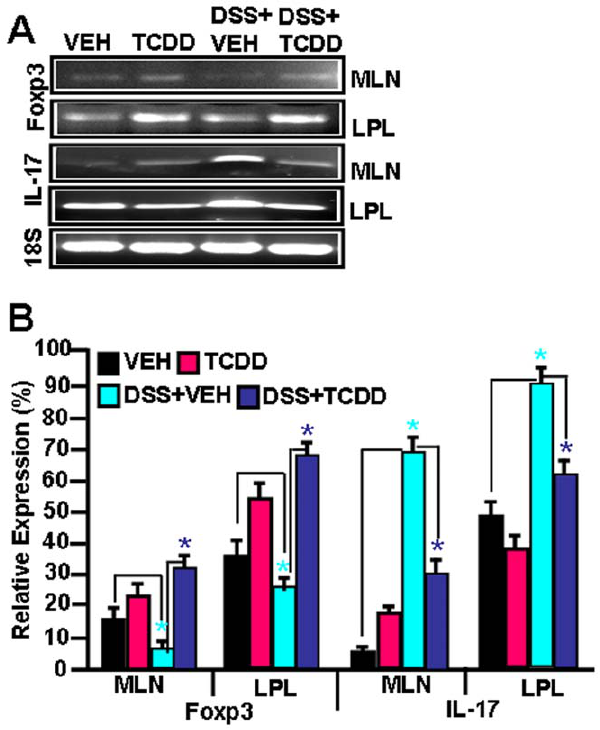
Figure 3. Effect of TCDD administration invivo on Foxp3 and IL-17 expression in lymphoid organs during colitis. MLN, and LP cells were isolated on day 14 of colitis from the 4 groups of mice as described in Fig. 1. RT-PCR was used to detect mRNA levels for Foxp3 and IL-17 (panel A) and data from 3 independent experiments in each group is shown in panel B. Vertical bars represent mean + / 2 SEM of three independent experiments. Comparisons were made between VEH vs DSS + VEH groups as well as between DSS + VEH vs DSS + TCDD groups. Asterisks (*) represent statistically significant (p , 0.05) difference between VEH and DSS + VEH groups and between DSS + VEH and DSS + TCDD groups.